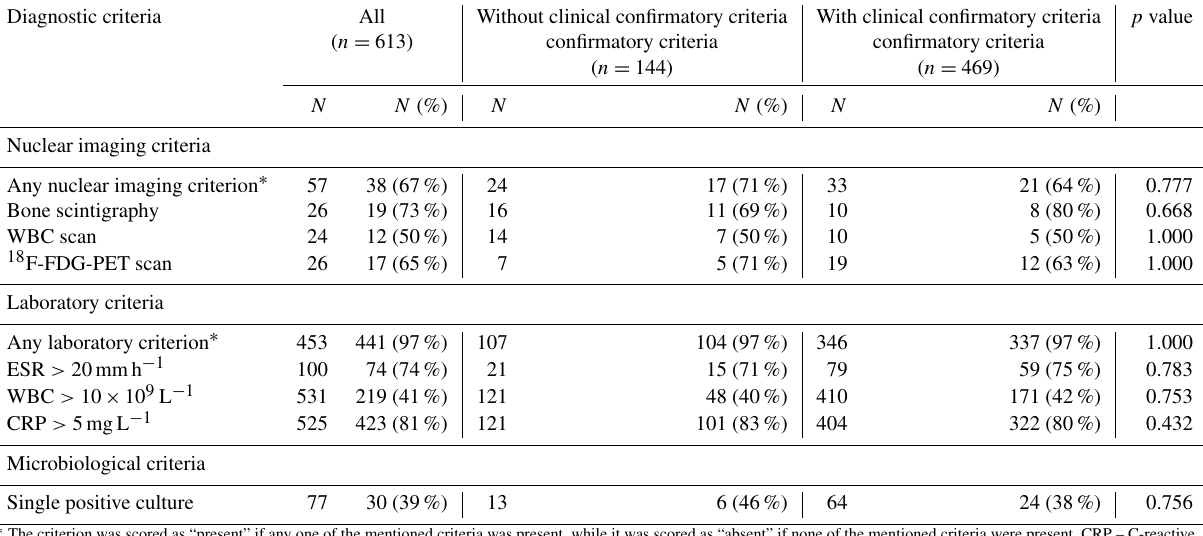
started (Govaert et al., 2020). In our cohort, any of these clin- ical confirmatory criteria was present in 469 (77 %) of the infected